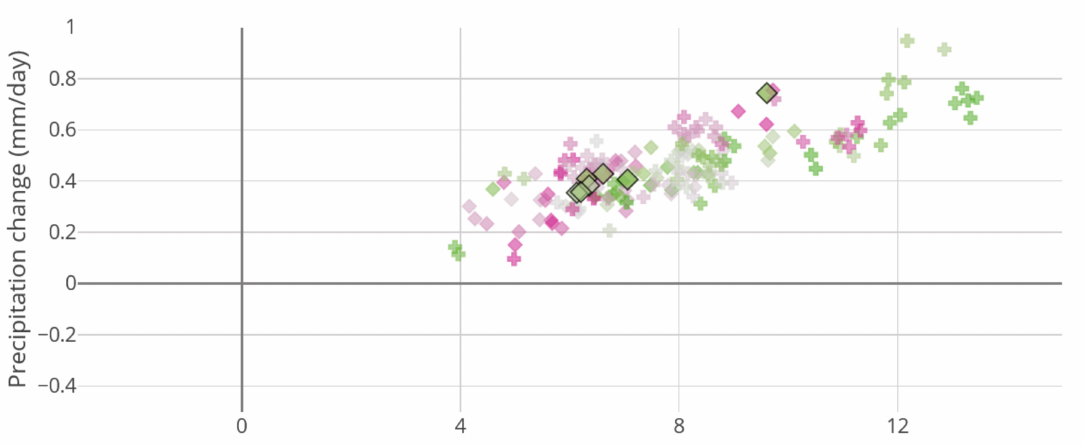
Figure 2. Global climate model sensitivities plotted as changes of annual mean temperature (x-axis) and precipitation (y-axis), 2071–2100 minus 1981–2010, under RCP 8.5 (CMIP5, diamond symbols) and SSP5/RCP-8.5 (CMIP6, cross symbols) forcing scenarios. Black-bordered symbols denote CCSM4 (cluster of 6-member ensemble in center) and GFDL (upper right). Green ensemble members perform well in predicting precipitation in Alaska, using the GPCP reanalysis as a reference, whereas red ensemble members perform poorly. Data taken from the Norwegian Meteorological Institute (https: //gcmeval.met.no/, accessed on 27 January 2022)